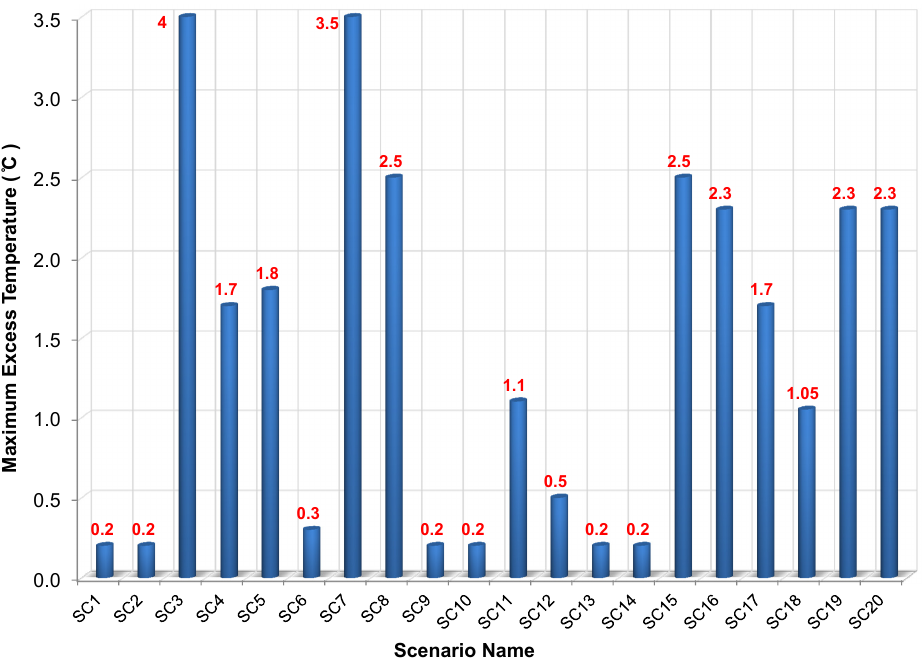
Figure 11. Maximum excess temperature at the intake location for all model scenarios.